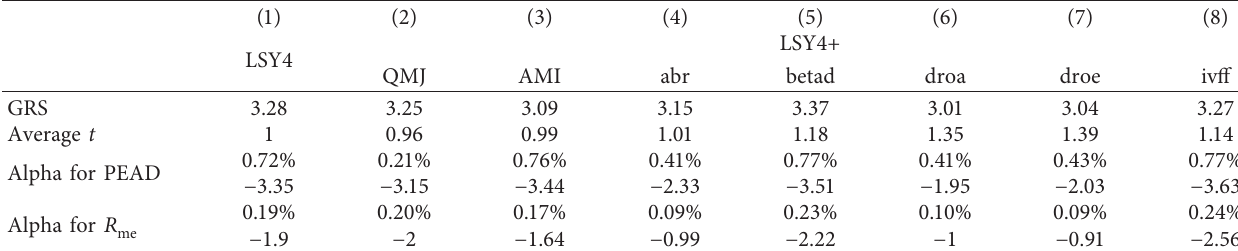
Table 11: Comparision of new factors in explaining anomalies. This table reports results of explaining 104 anomalies using augmented Liu–Stambaugh–Yuan 4-factor models [15]. The first column corresponds to our baseline result. We add seven new factors into the Liu–Stambaugh–Yuan 4-factor model one by one, including Quality-Minus-Junk, liquidity, cumulative abnormal returns around earnings’ announcement dates, Dimson beta, 4-quarter change in return on assets, and 4-quarter change in return on equity and idiosyncratic volatility per the FF3 model, in columns labeled “QMJ,” “AMI,” “abr,” “betad,” “droa,” “droe,” and “ivff.” The first two rows display GRS statistics proposed by Shanken et al. [24] and absolute average t -statistics of alphas over 104 anomalies. The last two rows display alpha estimates and corresponding t-statistics (in parentheses) of regressing PEAD and R on augmented models. PEAD is the short horizon me is the size factor in the Hou–Xue–Zhang q5-factor model factor in the Daniel–Hirshleifer–Sun 3-factor model [22]. R me